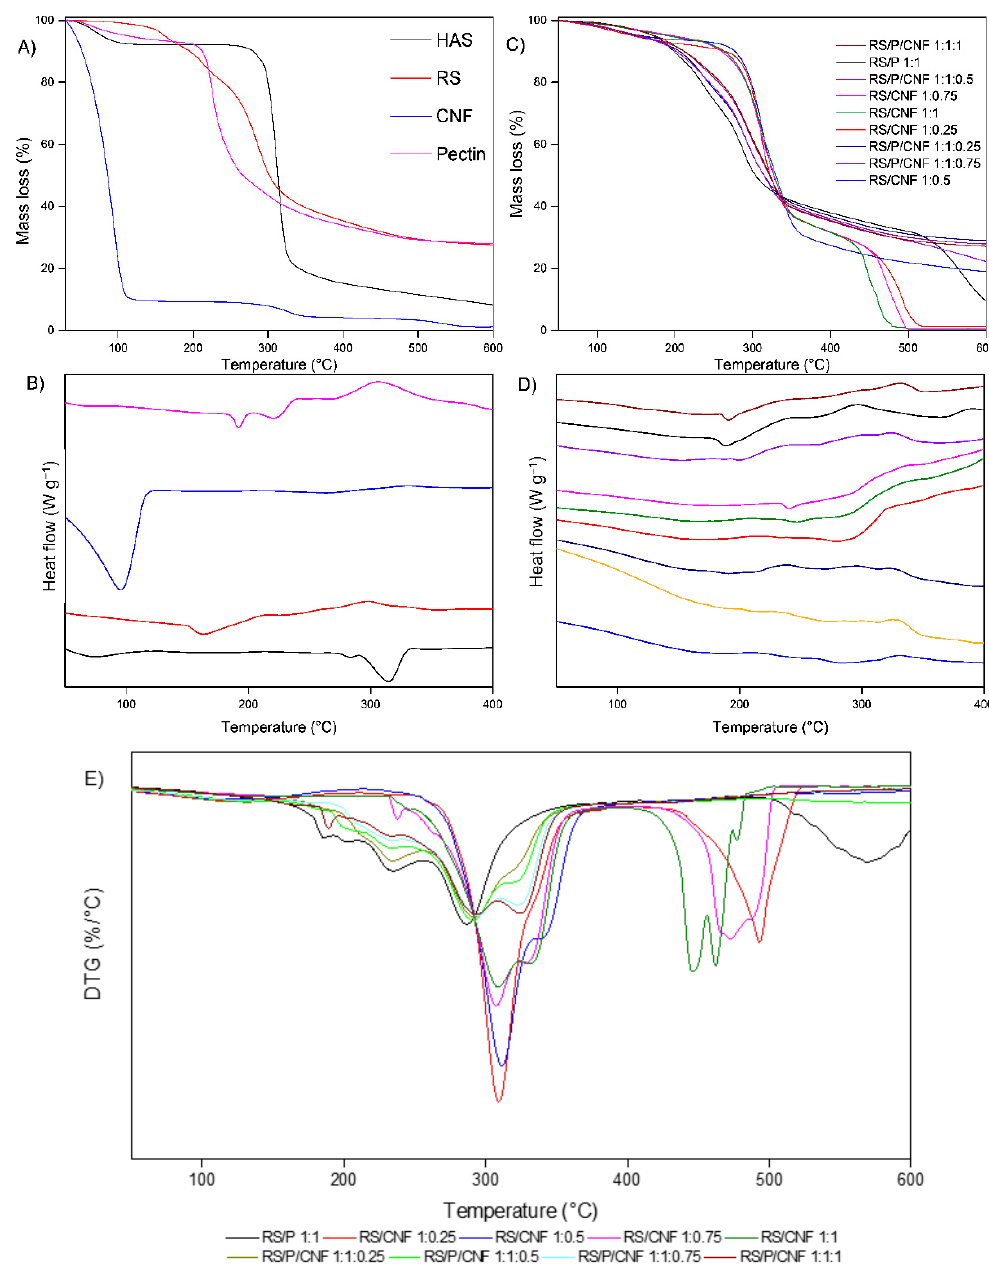
Figure 2. TG-DSC curves of isolated compounds and samples retrograded in the presence of pectin and/or CNF. TG curve ( A ) and DSC curve ( B ) of RS, HAS, Pectin, CNF. TG curve ( C ) and DSC curve ( D ) of RS/CNF and RS/P/CNF in different proportions. DTG curve of the RS in presence of different P and CNF proportions ( E ).